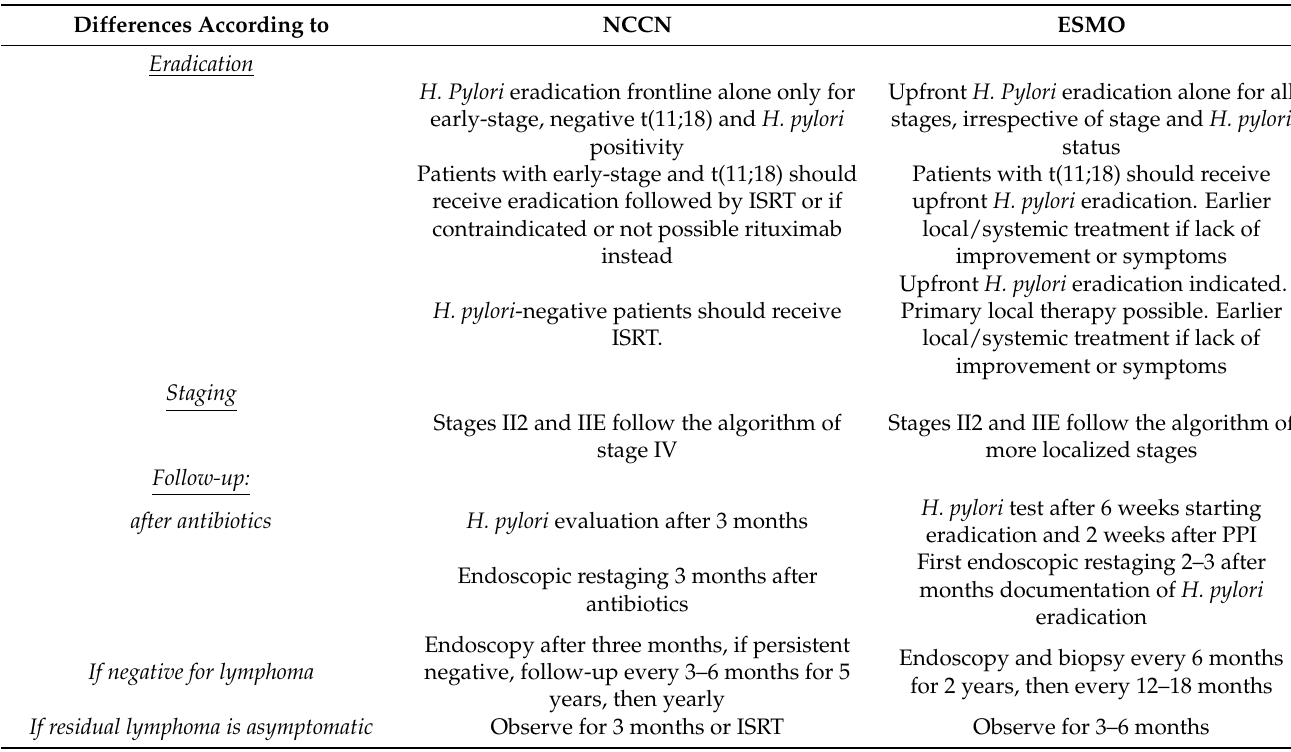
Table 3. Differences between European and American guidelines for gastric